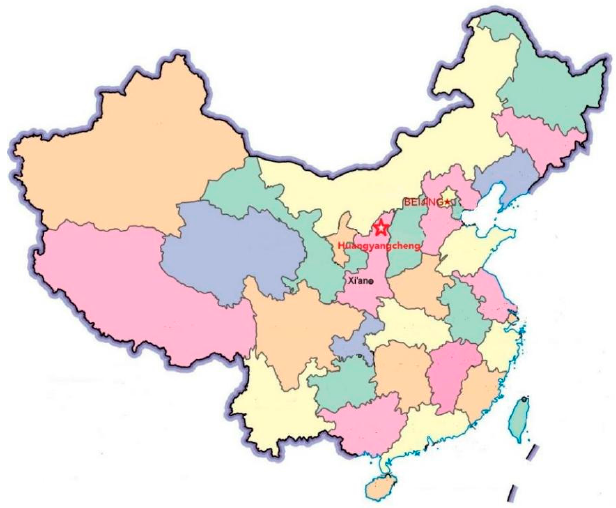
Figure 8. Location of Huangyangcheng Station.